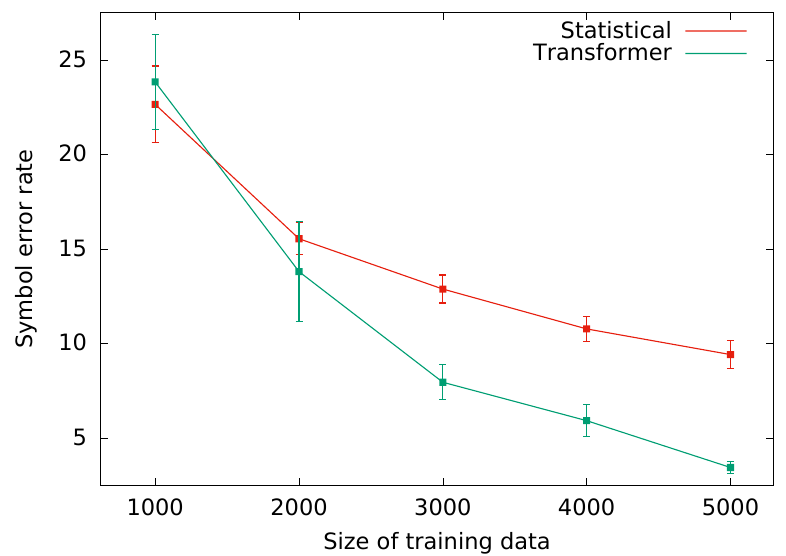
Figure 10. Mean symbol error rate (SER) and standard deviation, represented by vertical bars, obtained when training the statistical and the transformer neural approaches with subsets of the PRIMUS corpus of different sizes.